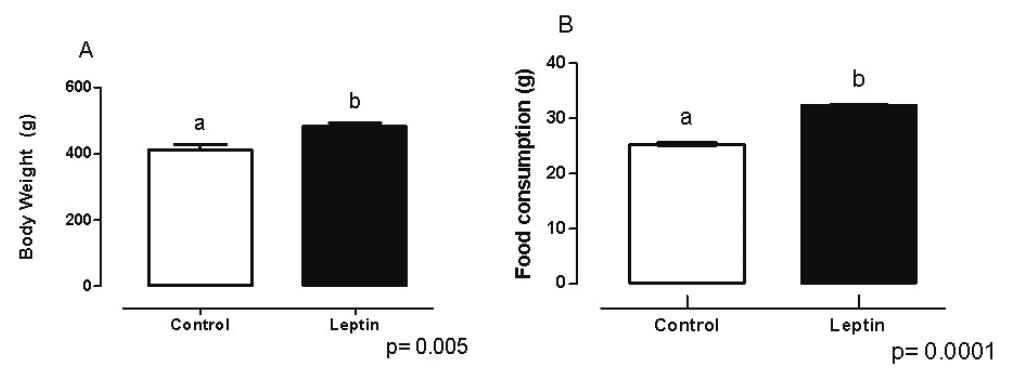
FIGURE 1 - Body weight ( A ) and food consumption ( B ) in control and leptin treated groups. Values are given as mean ±SEM of 6